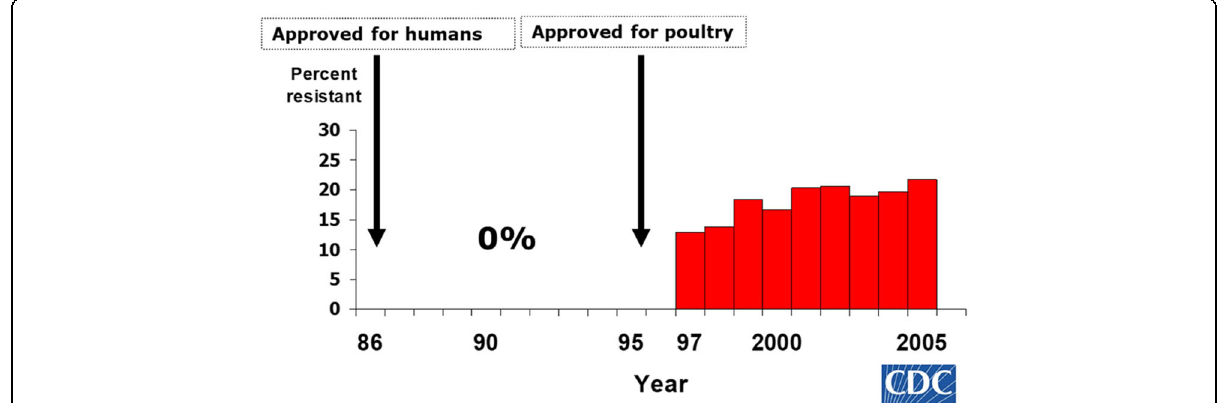
Fig. 7 Percent fluoroquinolone resistant Infections In humans In USA 1986 – 2005 (Source: